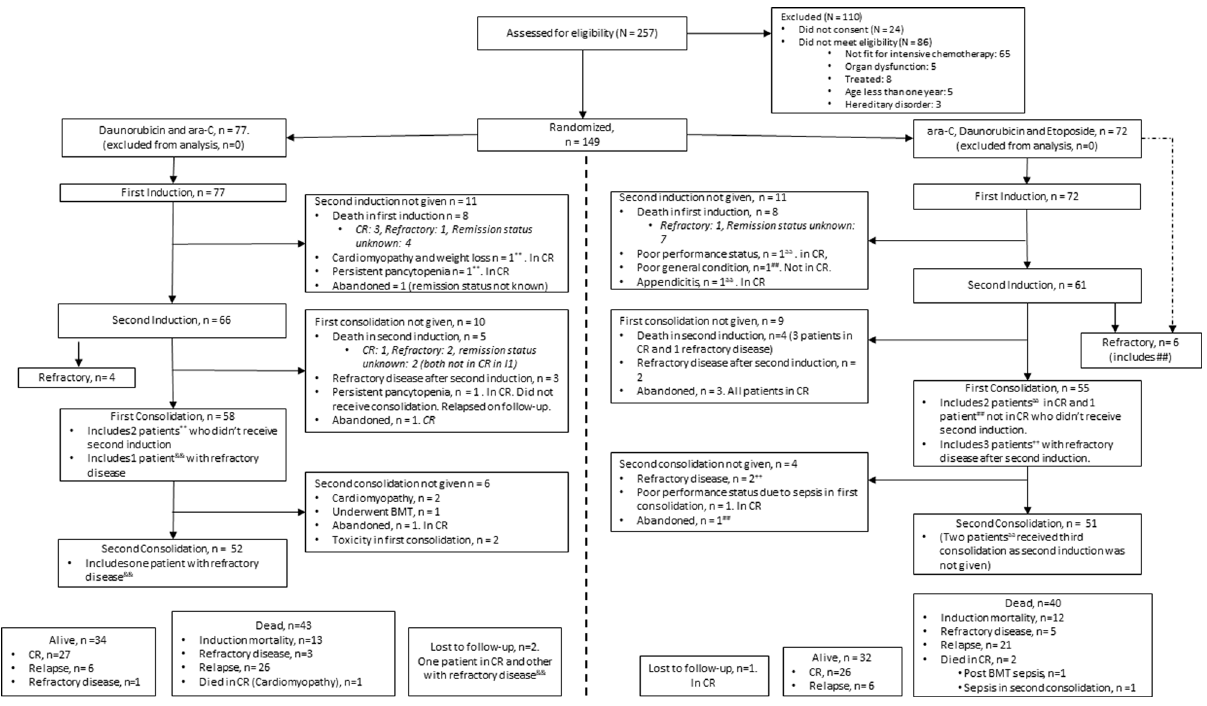
Fig. 1 Study consort